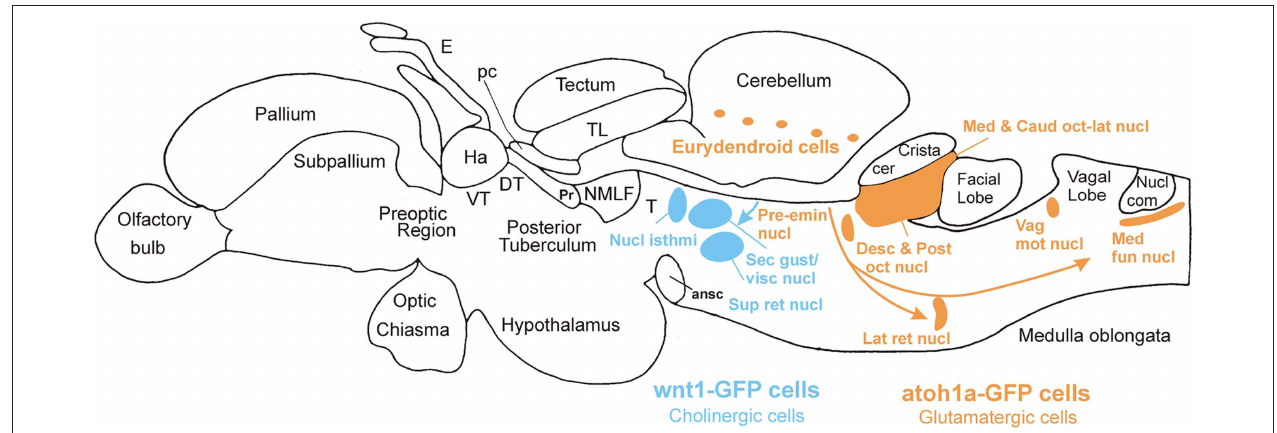
epiphysis; Ha, habenula; Lat ret nucl, lateral reticular nucleus; Med fun nucl, medial funicular nucleus; NMLF, nucleus of medial longitudinal fascicle; Nucl com, nucleus commissuralis Cajal; Pc, posterior commissure; Pr, pretectum; Pre-emin nucl, pre-eminential nucleus; Sec gust/visc nucl, secondary gustatory/viscerosensory nuclei; Sup ret nucl, superior reticular nucleus; T mesencephalic, tegmentum; TL, torus longitudinalis; Vag mot nucl, vagal motor nucleus; VT,